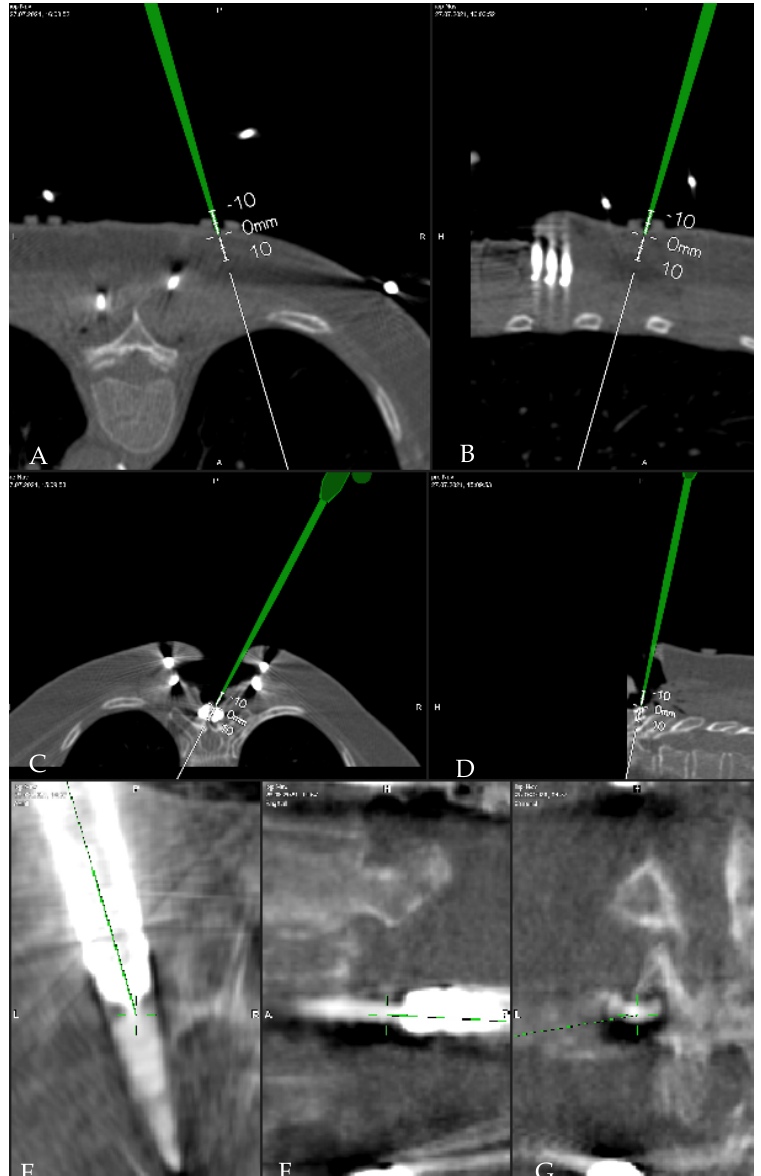
Figure 4. Registration accuracy check with tip of the pointer on ( A , B ) the skin fiducials ( C ). holder of the carbon reference array ( D ). the mini screw attached to the spinous process. ( E – G ). head of the screw.